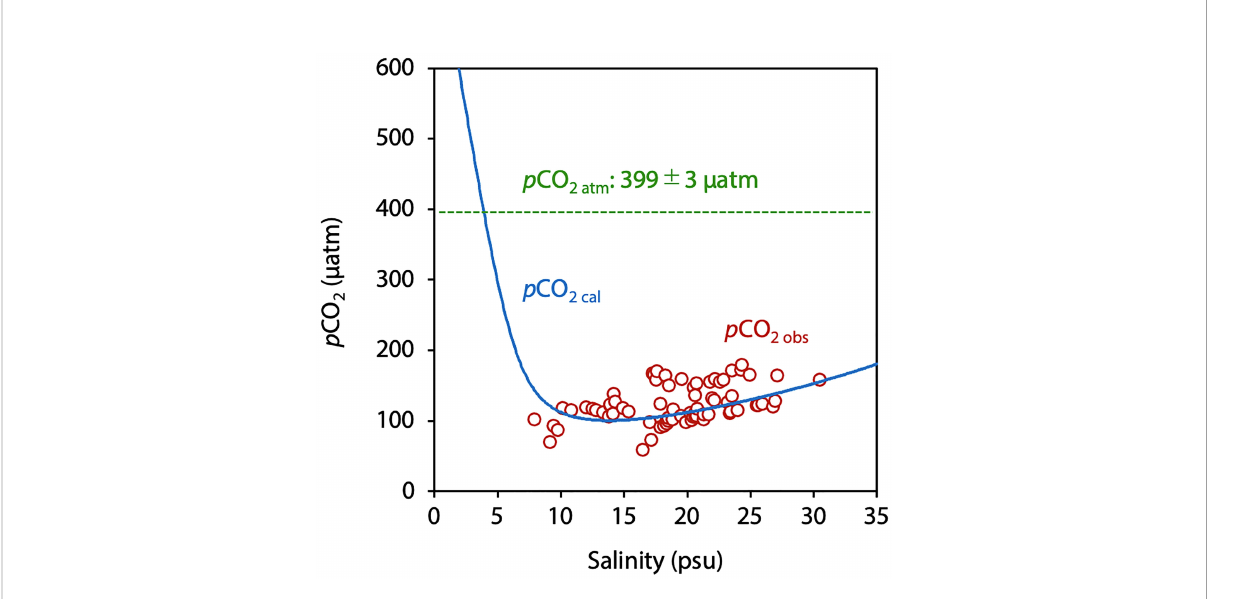
FIGURE 6 Relationship between p CO 2 obs or p CO 2 cal and